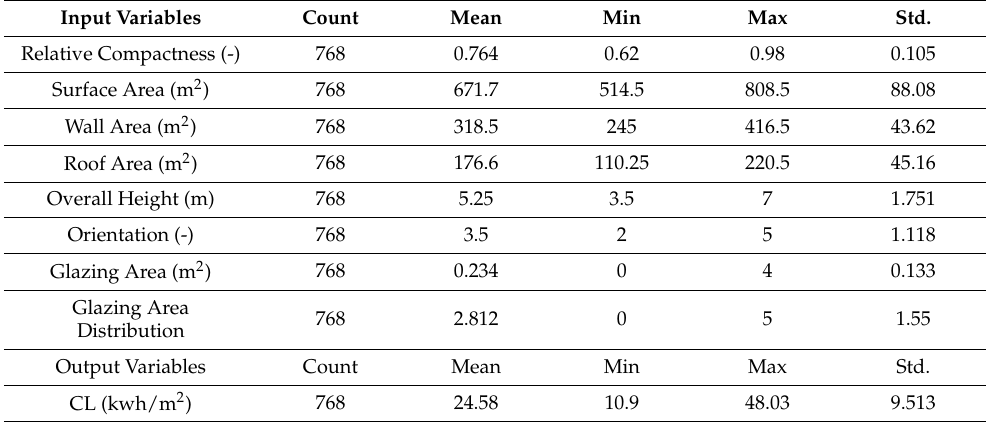
Table 1. Statistical summary of the input and output